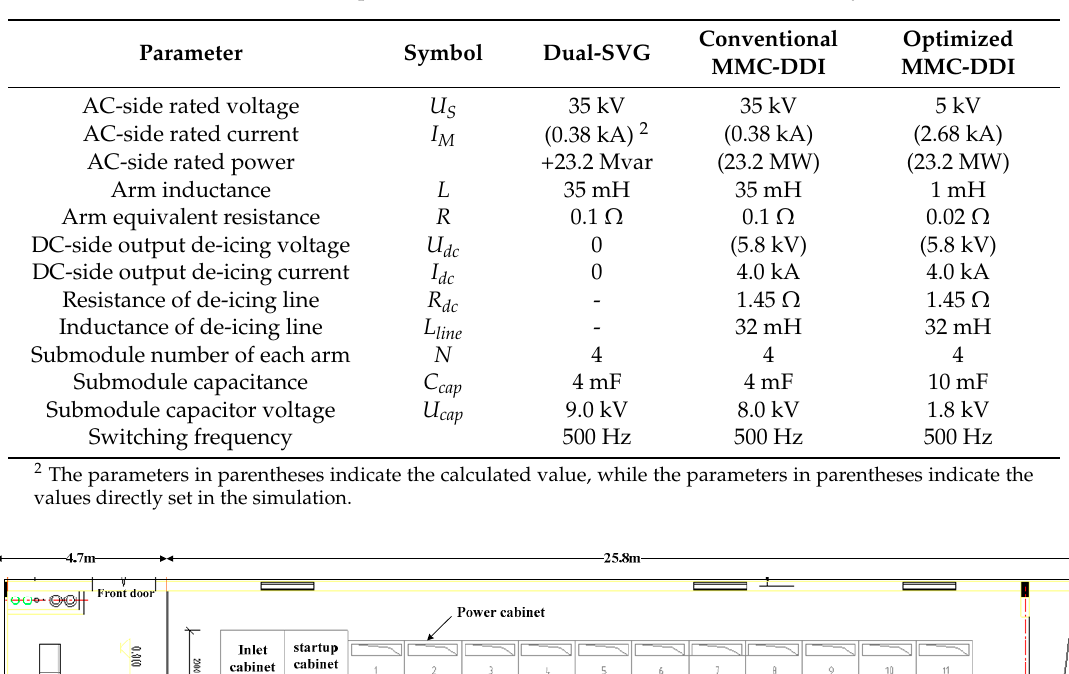
Table A4. Simulation parameters of the two MMC-DDI and dual-SVG systems.